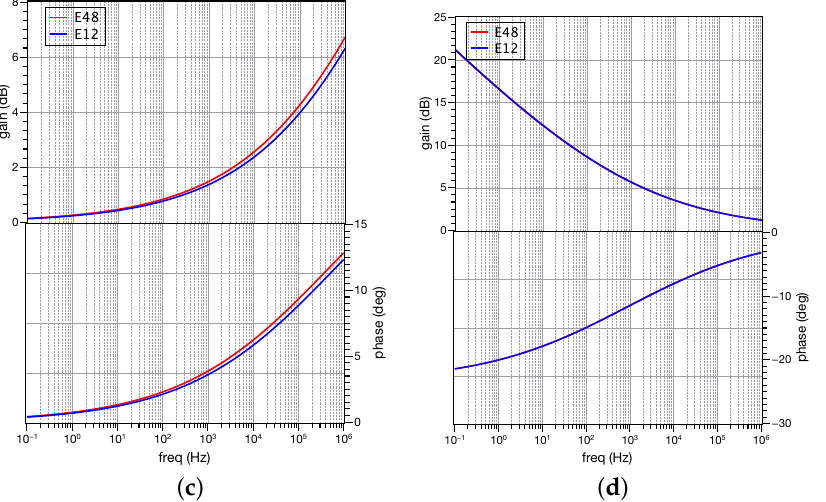
Figure 15. Evaluation of the effect of the error in the capacitors values on the frequency response of the ( a ) low pass, ( b ) high pass, ( c ) inverse low pass, and ( d ) inverse high pass